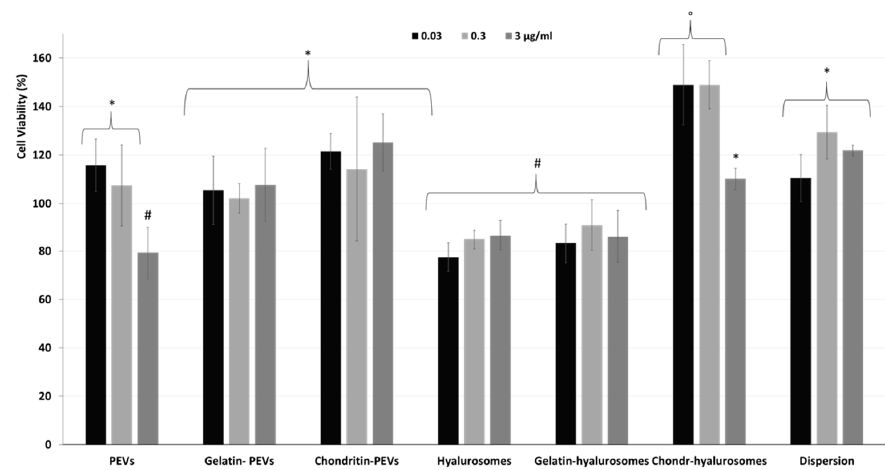
Figure 5. Viability of keratinocytes treated with C. halicacabum extract in dispersion or loaded in PEVs; gelatin-PEVs; chondroitin-PEVs; hyalurosomes; gelatin-hyalurosomes; and chondroitin-hyalurosomes, at different dilutions (extract 0.03, 0.3, 3 µ g/mL). Data represent the means ± standard deviations of at least three experimental determinations. Each symbol (*, # , ◦ ) indicates the same value.